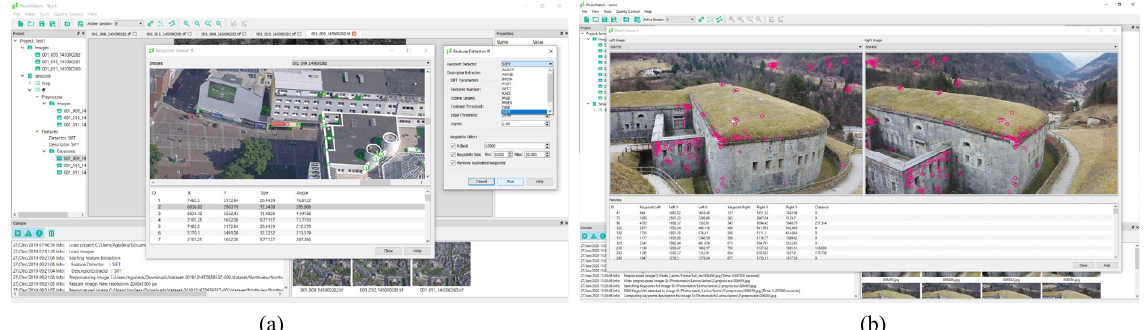
Figure 2: Different keypoint detectors and descriptors available in PhotoMatch (a) and results of UAV image pair matching (b).